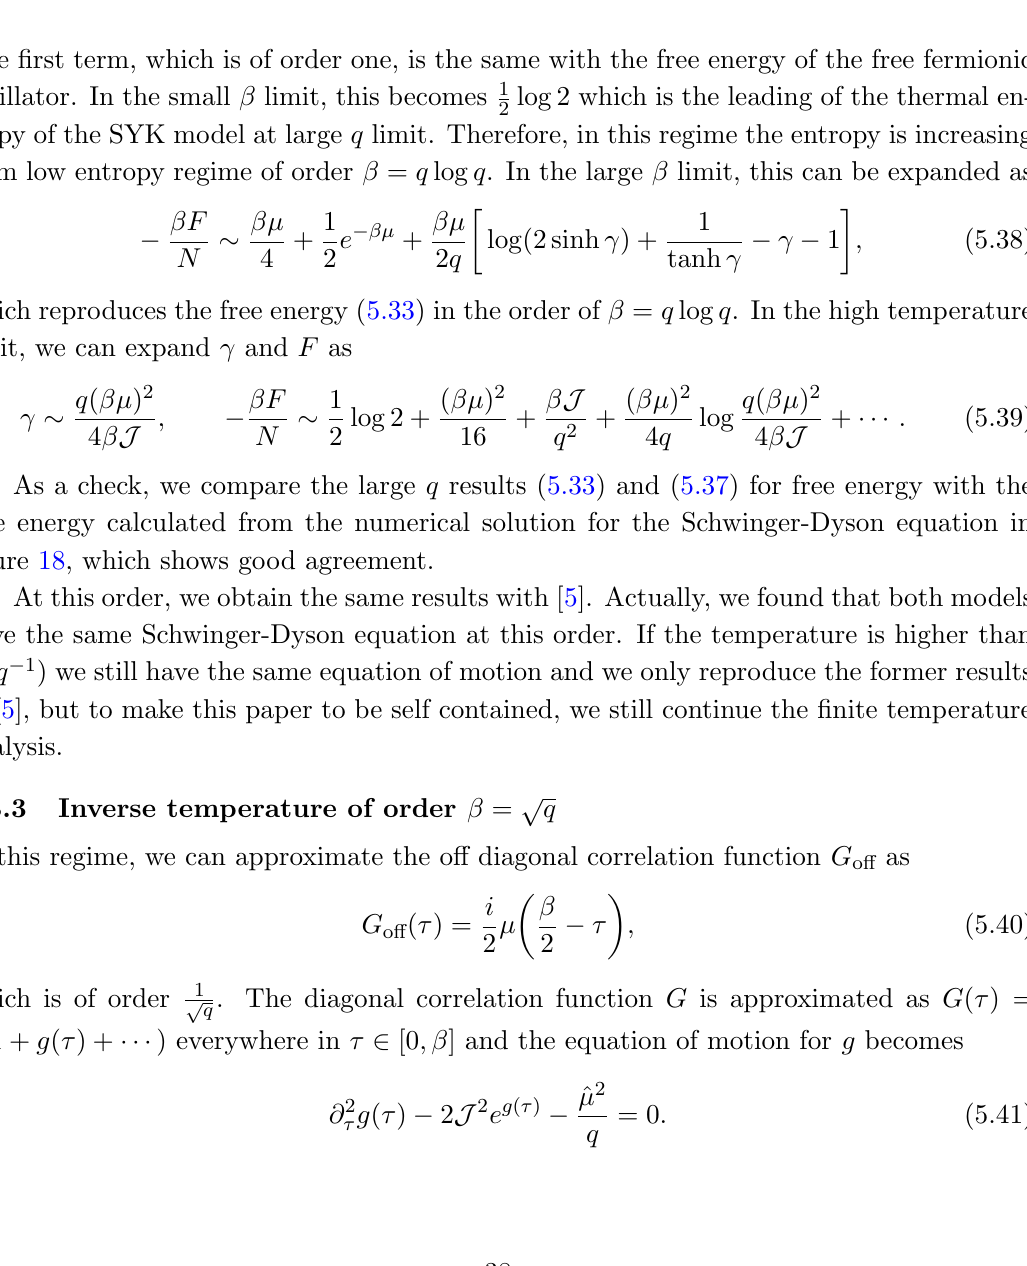
Figure 18 . Plot of free energy. The numerical calculation is done for q = 96, The red and orange lines are analytical results (5.33) and (5.37) for the large q